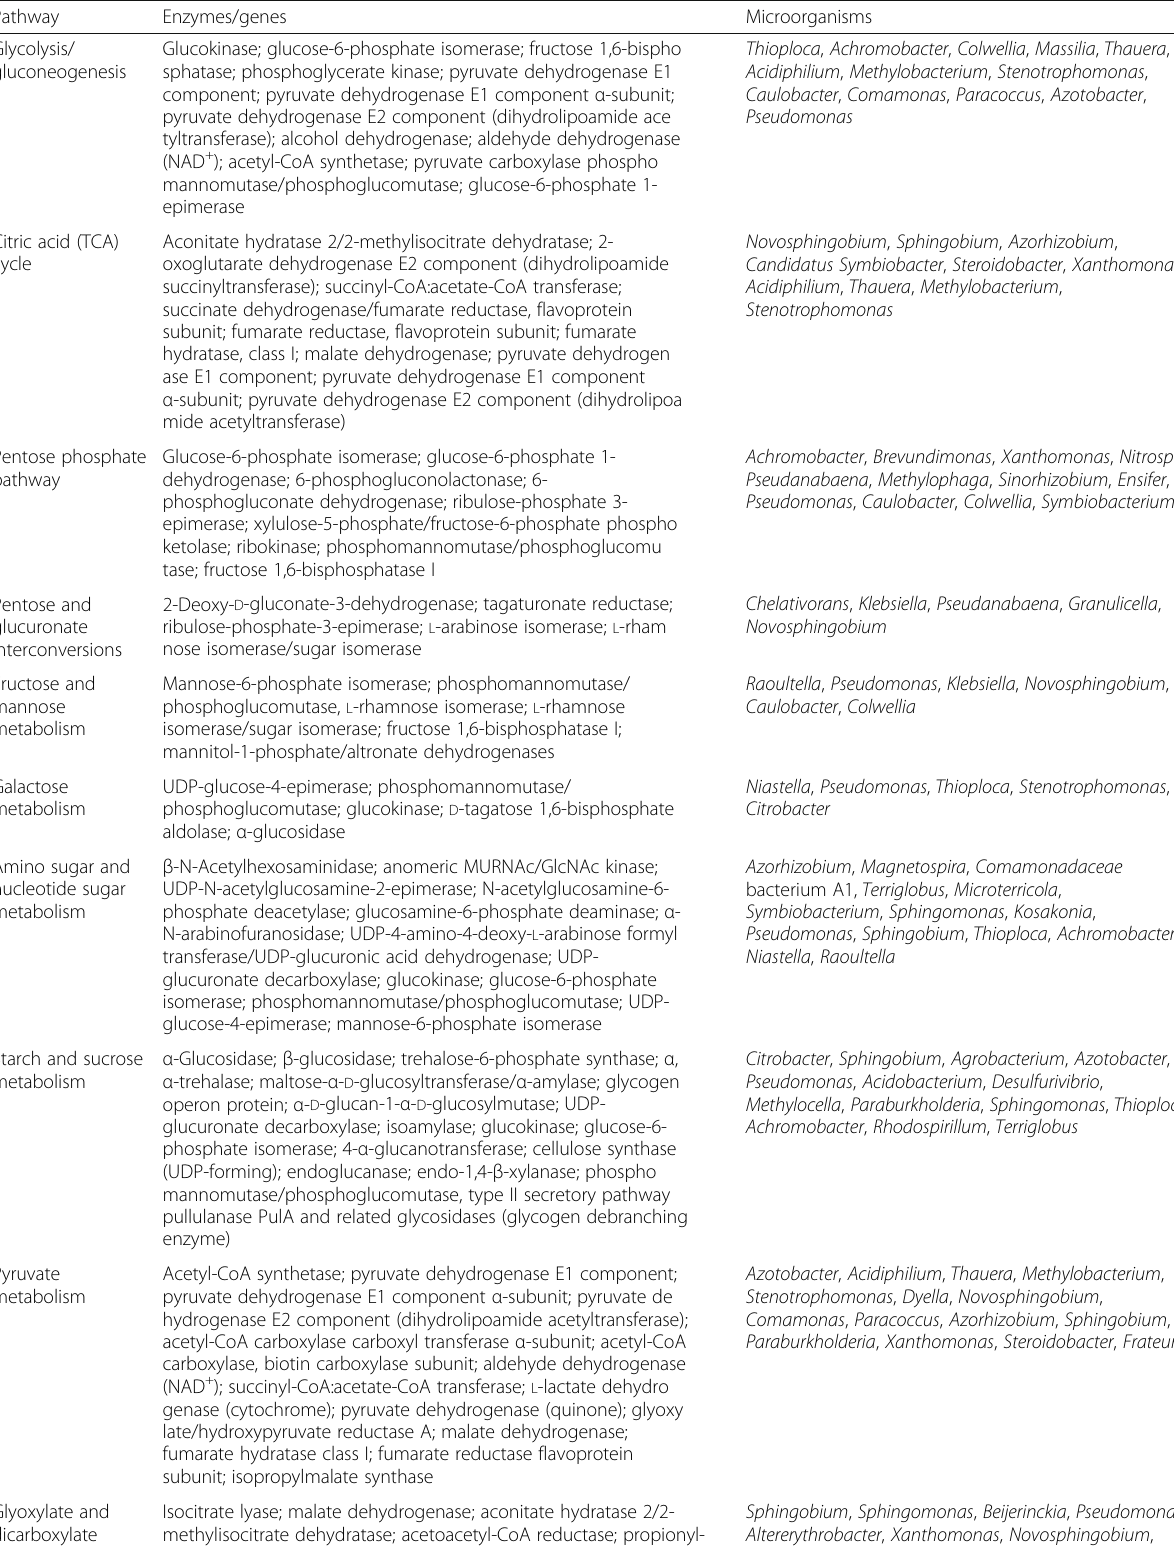
Table 1 List of the enzymes/genes and microorganisms detected in AB1 microcosm involved in diverse metabolism of